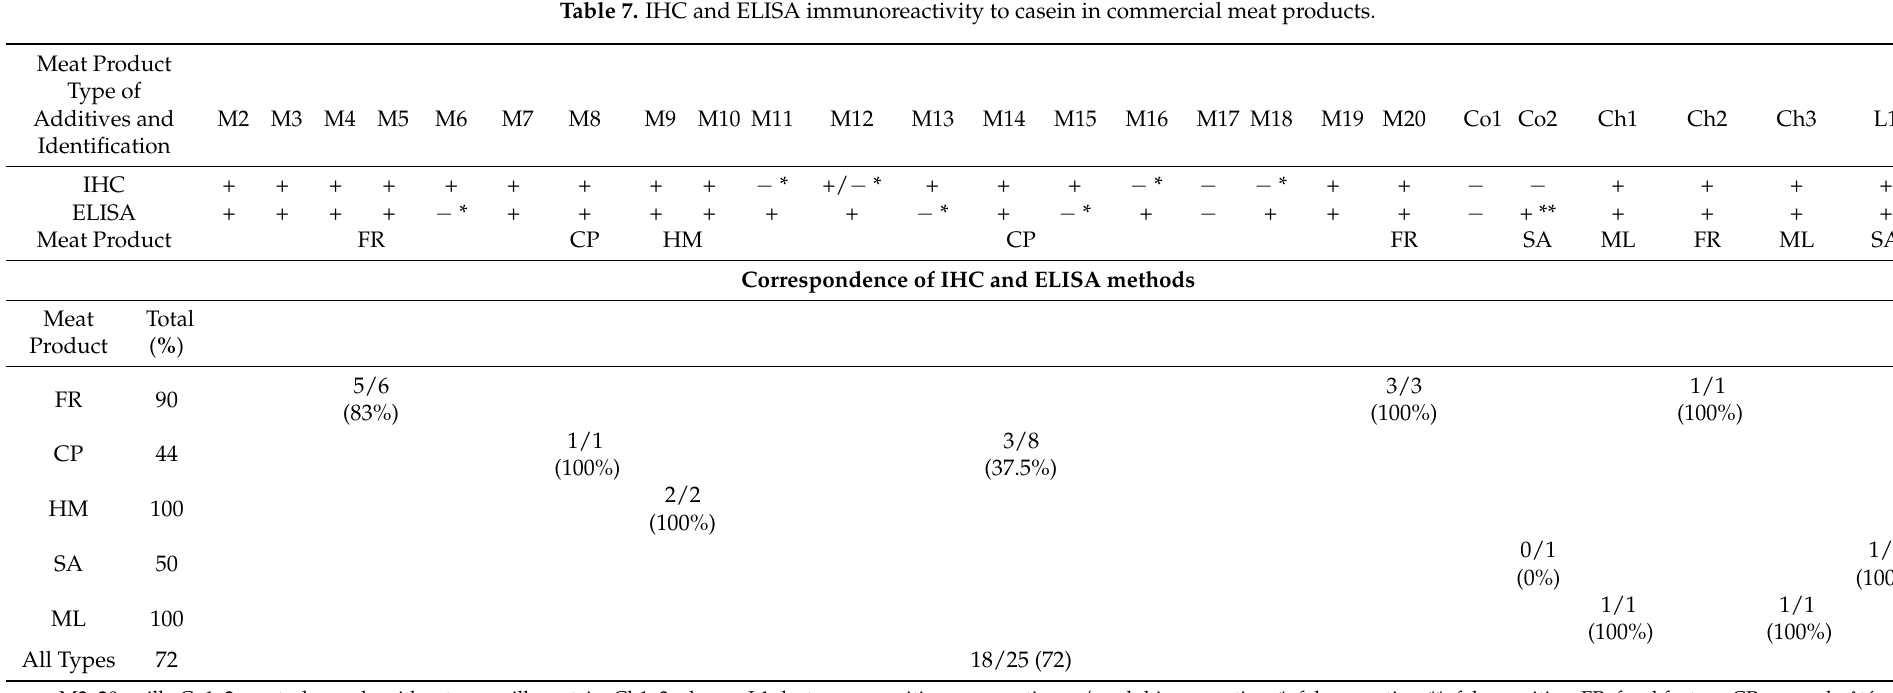
Table 7. IHC and ELISA immunoreactivity to casein in commercial meat